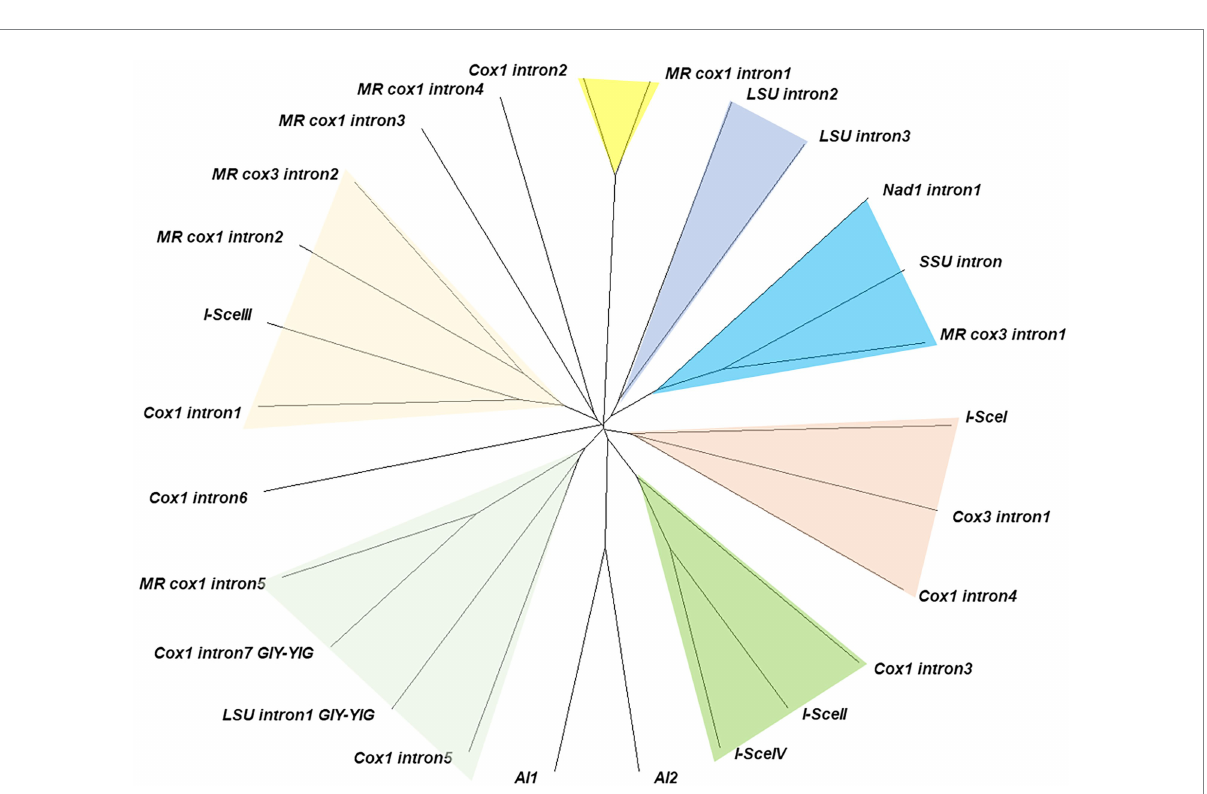
FIGURE 6 Grouping of intronic HEGs. Similar HEG groups are color-shaded. HEGs from introns in the genes of M. roreri are described as ‘ MR gene name intron ’ while HEGs of Saccharomyces cerevisiae are described following HEG naming rule. The unrooted tree was constructed using translated protein sequences by Neighbor-Joining method.